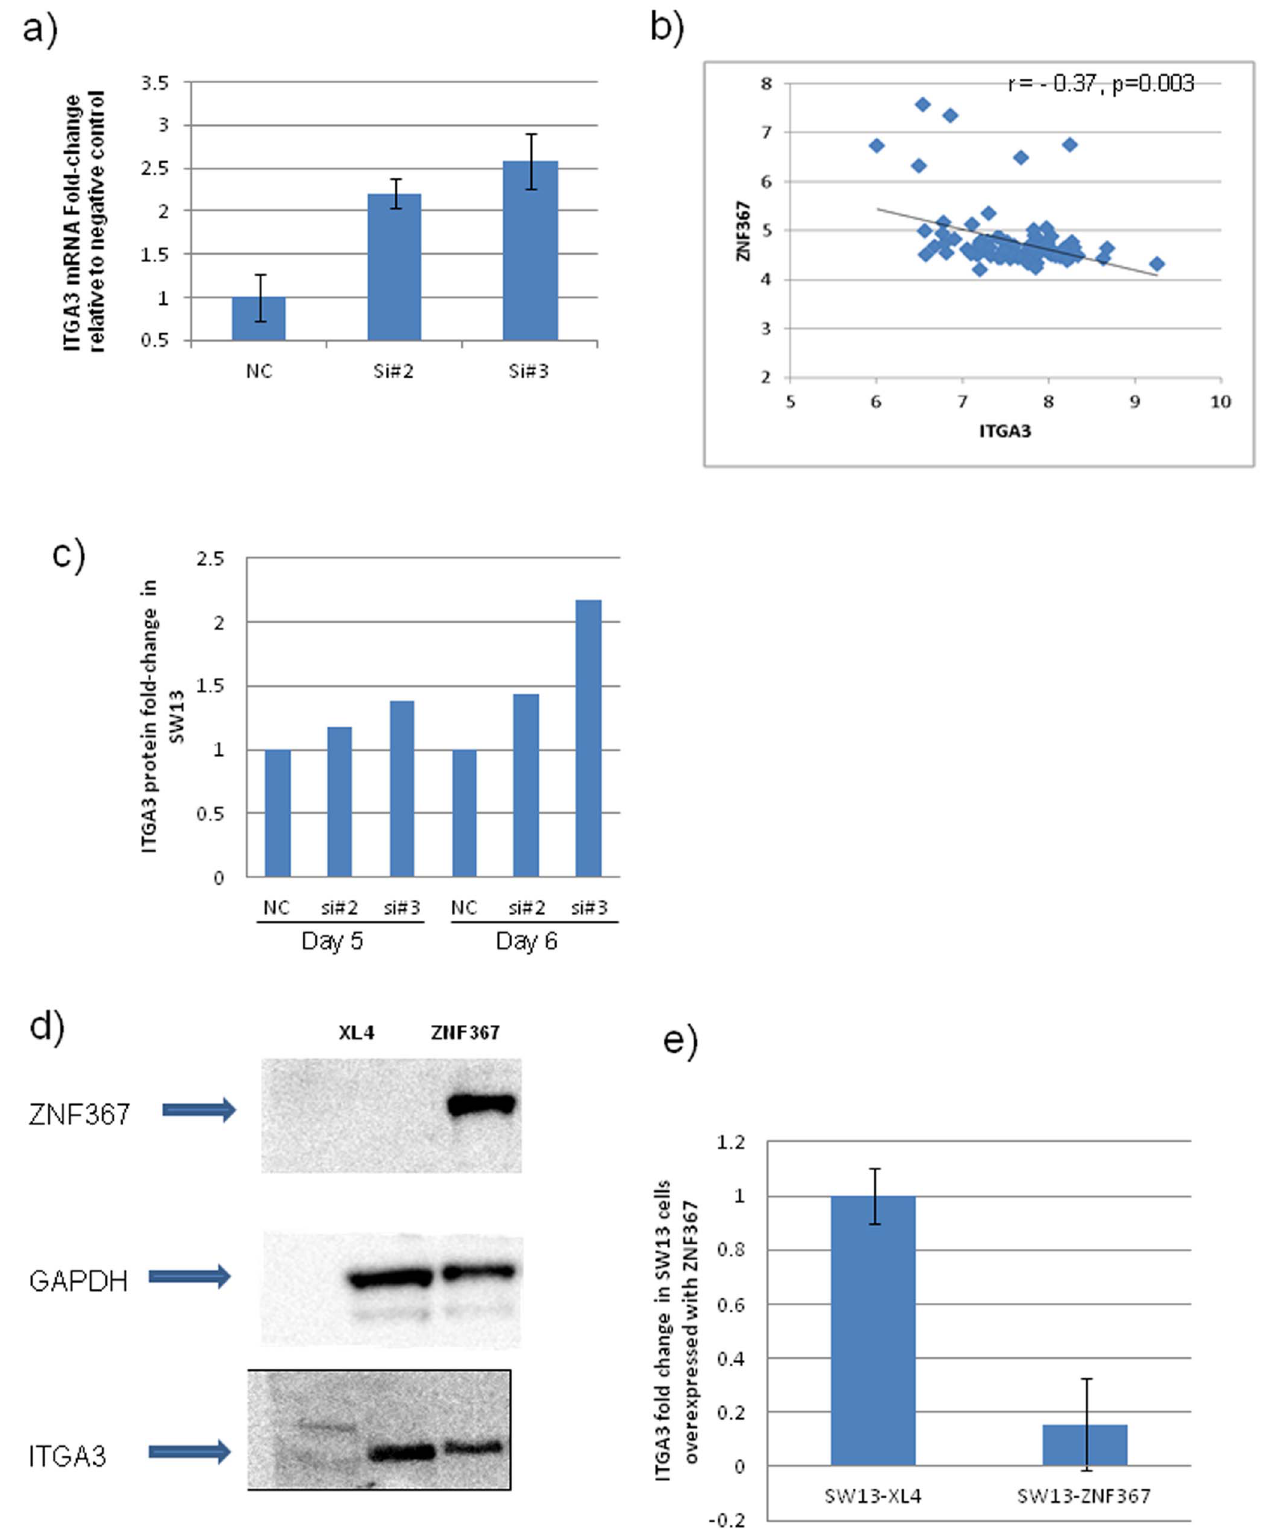
Figure 4. ZNF367 regulates ITGA3 expression. ( A ) ZNF367 knockdown upregulates ITGA3 expression in SW13 cells. Error bars represent 6 SEM. ( B ) The correlation between ITGA3 and ZNF367 mRNA expression in adrenocortical tumor samples. X and Y axes represent log 2–transformed values. ( C ) Western blot quantification of ITGA3 protein expression with ZNF367 knockdown. ( D – E ) ITGA3 expression with ZNF367 overexpression. Error bars represent 6 SEM.